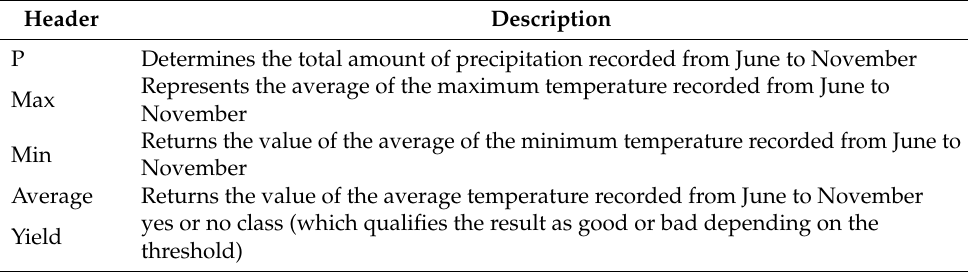
Table 1. Niger_Rice dataset headers description.